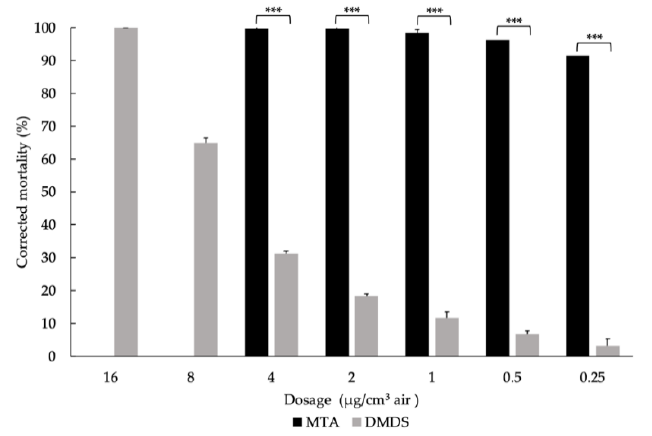
Figure 3. Comparison of the mortality caused by DMDS and MTA at different dosages against the root-knot nematode M. incognita for 24 h. Bars indicate the standard error (SE) of the means. Statistical comparisons were performed with Student’s t-test. *** denotes p -value < 0.001. The worms used in the treatments were J2s.